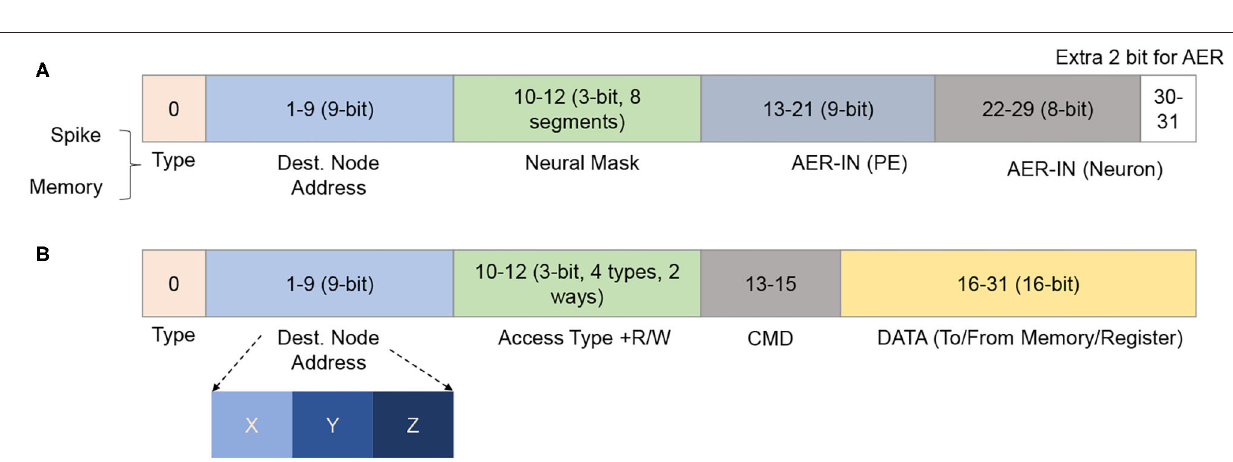
FIGURE 3 | R-NASH architecture. (A) Neuromorphic System. (B) Network-Interface. (C) 3D-Router. (D) SNPC Core.